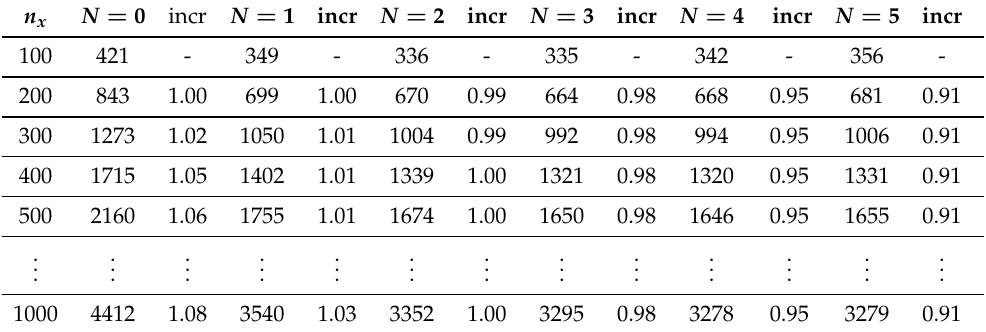
Table A4. First term of eigenvalue Λ max for different N and n x , and constant λ = 10 − 4 . For a visualization, see Figure 9.